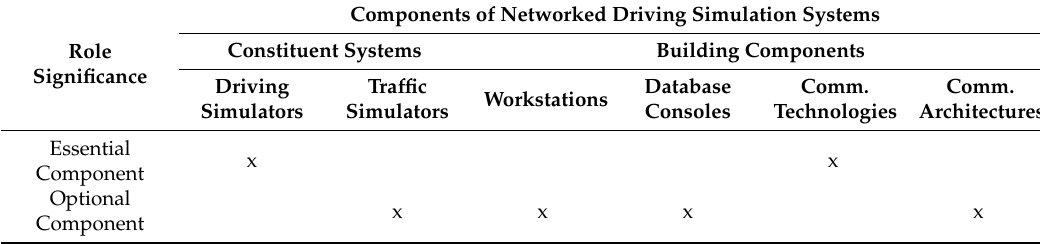
Table 9. Role significance of constituent systems and building